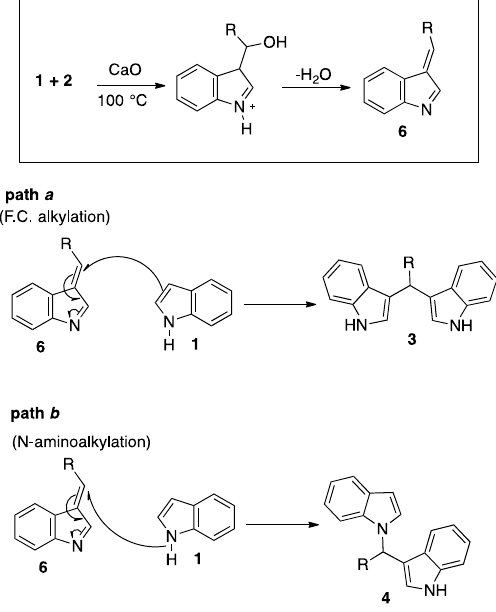
Scheme 4. Proposed reaction